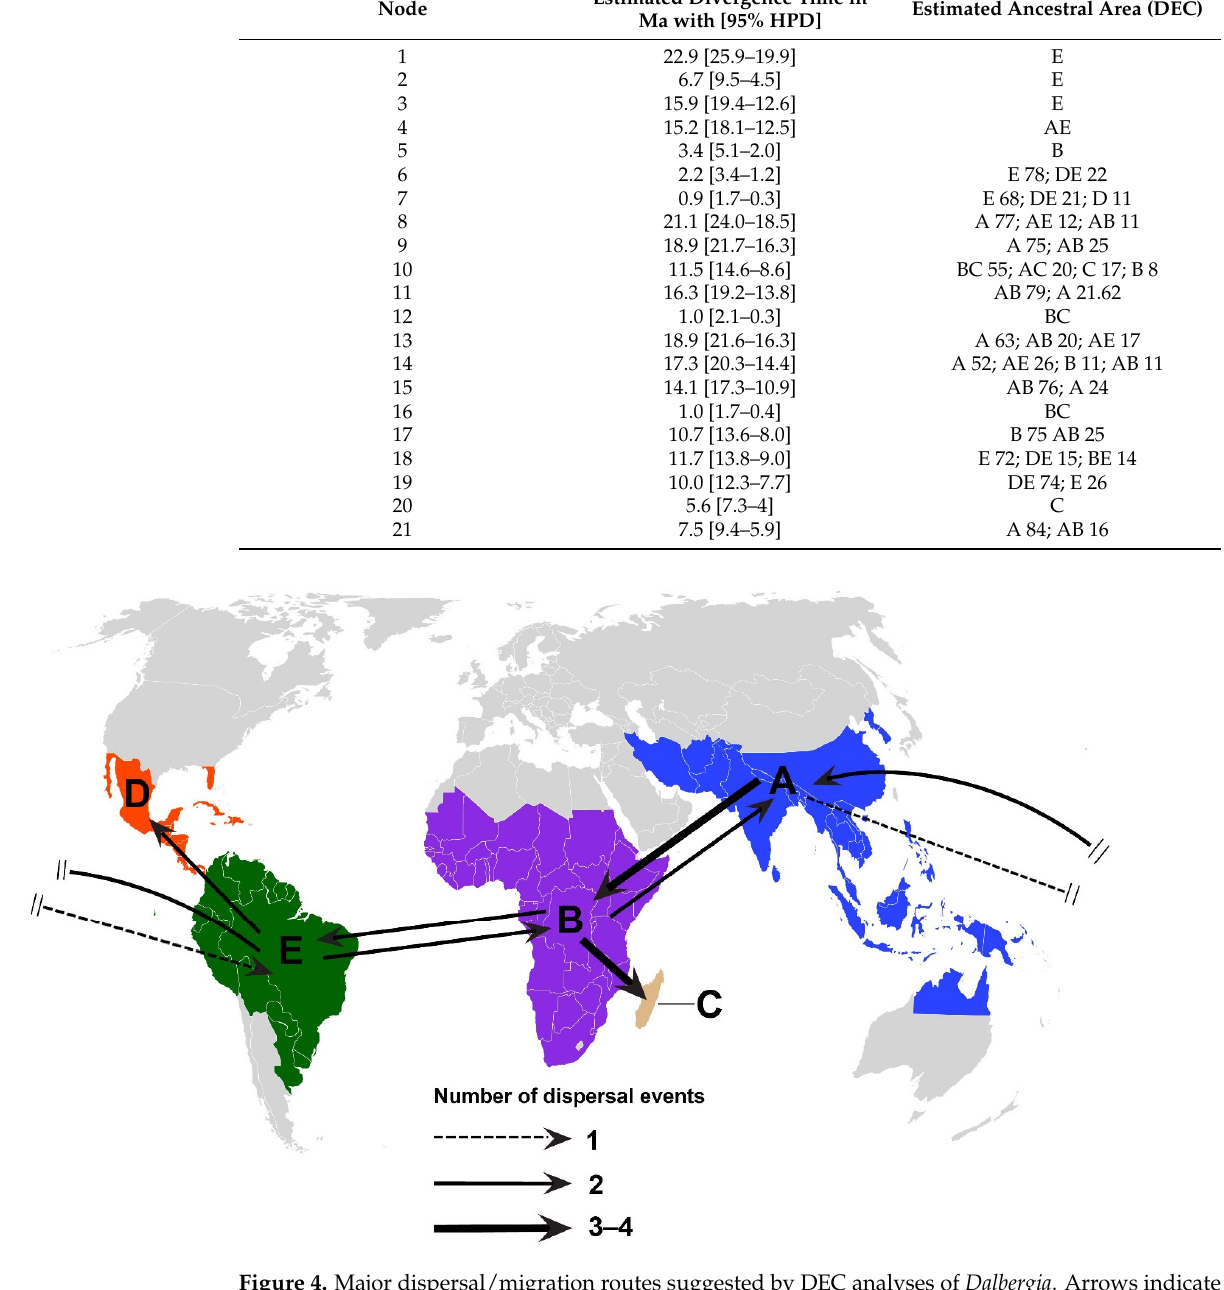
Figure 4. Major dispersal/migration routes suggested by DEC analyses of Dalbergia . Arrows indicate the dispersal direction; line thickness is proportional to the number of events. Labels A, B, C, D and E represent Australasia, Africa, Madagascar, Central America (including Florida and the Caribbean) and South America, respectively.